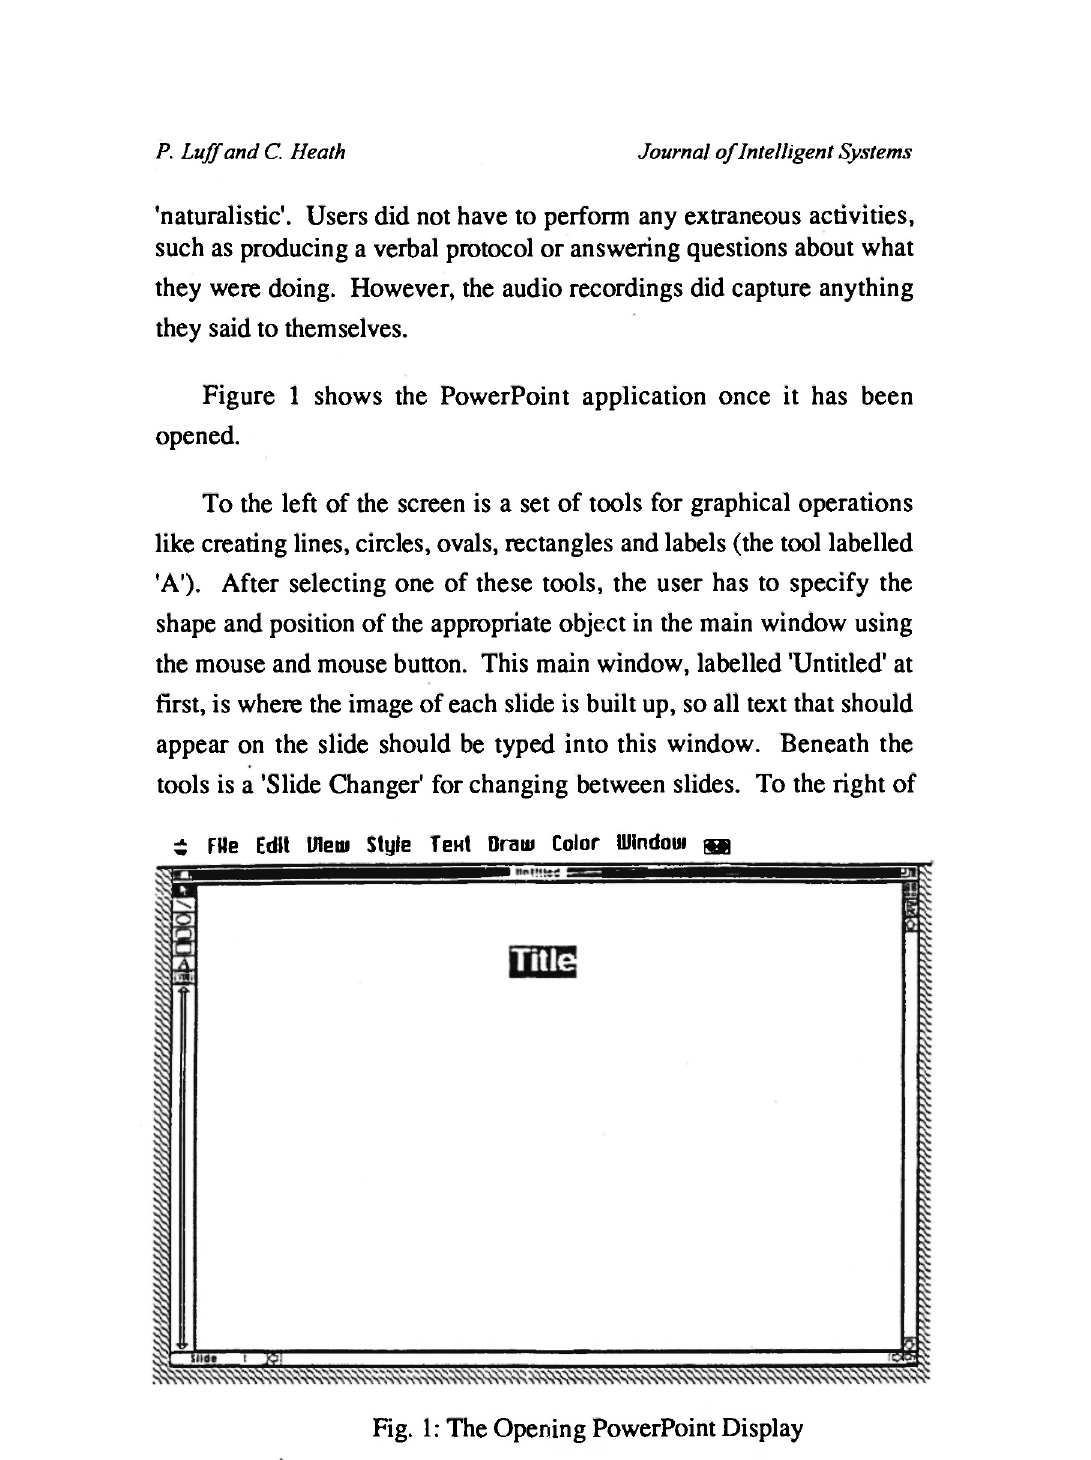
Fig. 1: The Opening PowerPoint